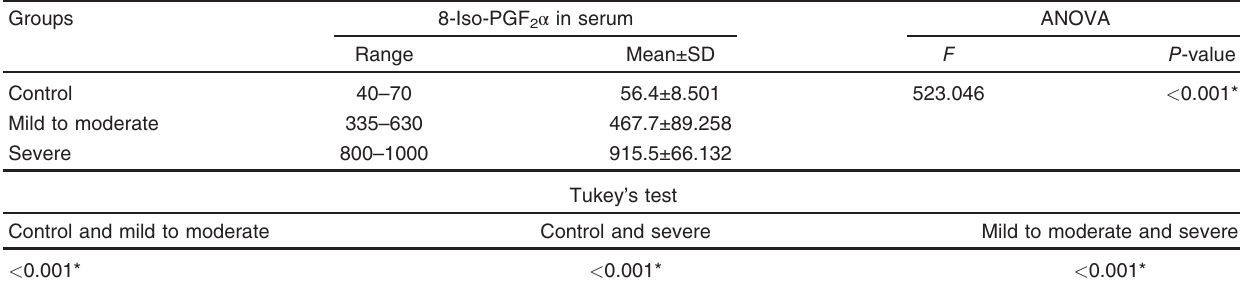
Table 4 Statistical comparison of range, mean±SD values of serum fluid levels of 8-isoprostane (ng/ml) in the three studied groups